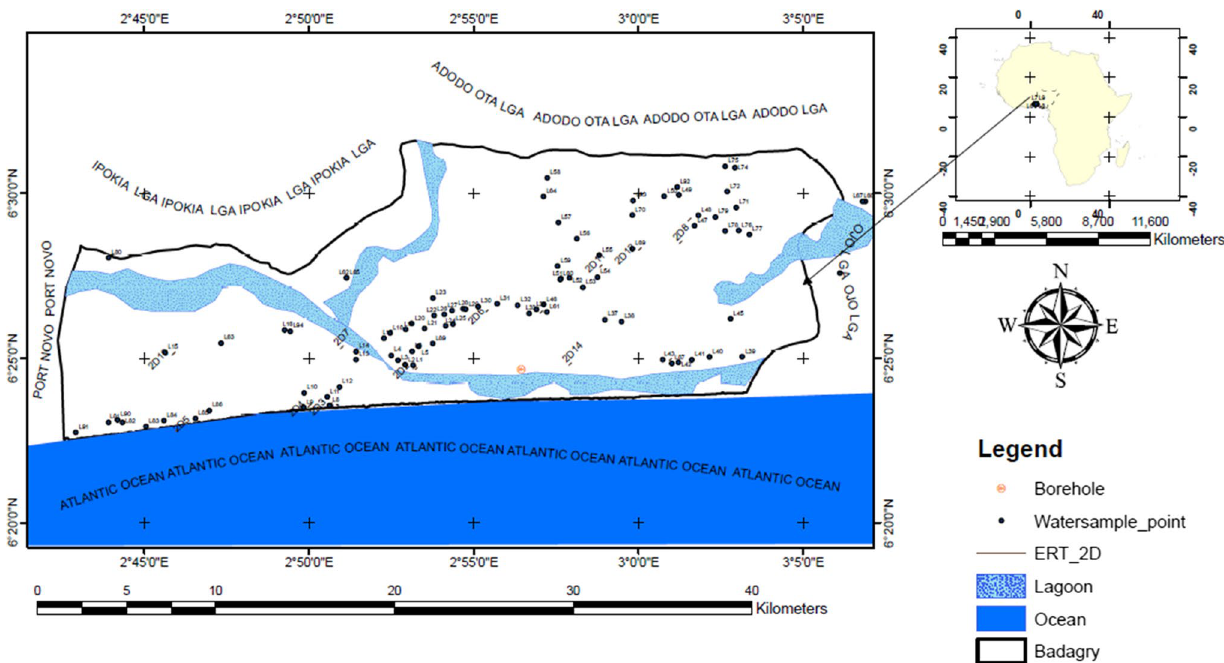
Fig. 2 Map of the area and survey